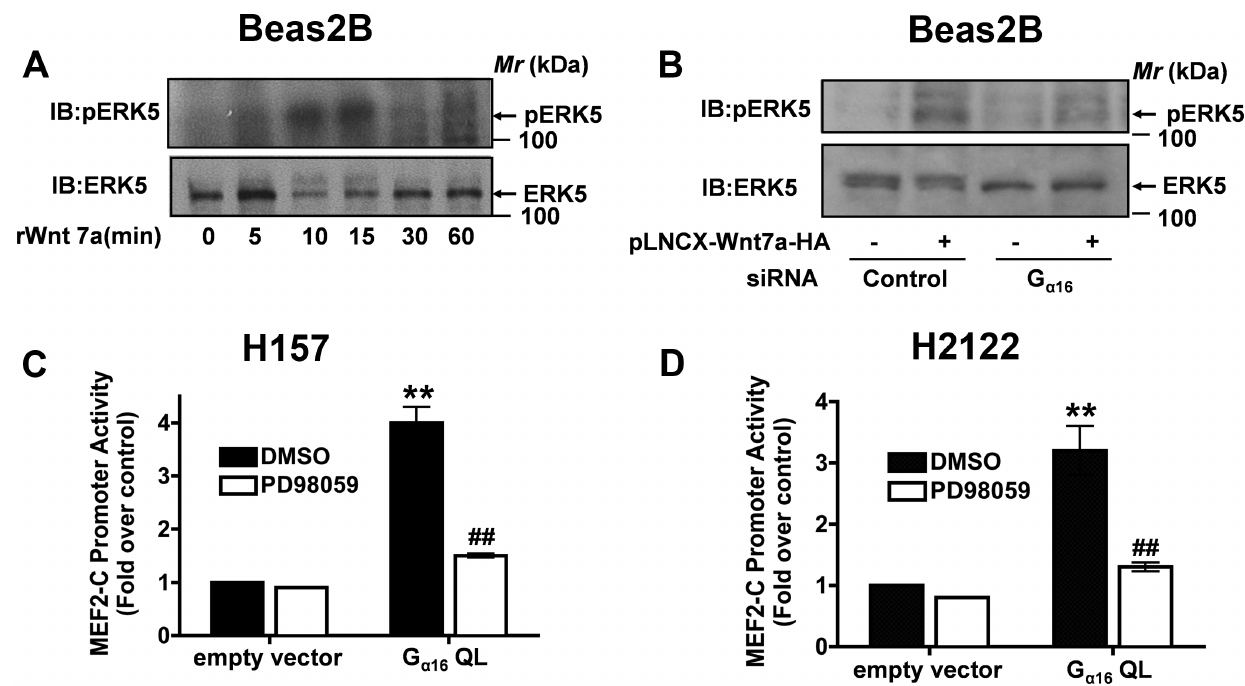
Figure 4. G a 16 regulates Wnt7a/Fzd9-mediated ERK5 activation. A, Beas2B cells were serum starved for 2 h and were later stimulated with recombinant Wnt7a. After stimulation for indicated periods of time, the cells were lysed, separated on SDS-PAGE gels and later probed for ERK5 activation by probing the nitrocellulose blots with anti-pERK5 antibodies and normalized for equal loading by probing with anti-ERK5 antibodies. B, Beas2B cells were transfected either with control siRNA or G a 16 -specific siRNAs together with or without Wnt7a expression vector. After 48 h, the cells were lysed and analyzed for ERK5 activation by probing the blots with anti-pERK5 and ERK5 antibodies. NSCLC cell lines, H157 (C) or H2122 (D) cells were transfected either with empty vector or G a 16 Q212L together with MEF2-C-dependent luciferase reporter, followed by a treatment either without or with MEK inhibitor PD98059 (20 m M). After 24 h, the lysates were assayed for luciferase activities as described in the Methods. Data represents mean 6 SEM of three separate experiments. **, p , 0.01; versus empty vector control. ## , p , 0.01; versus G a 16